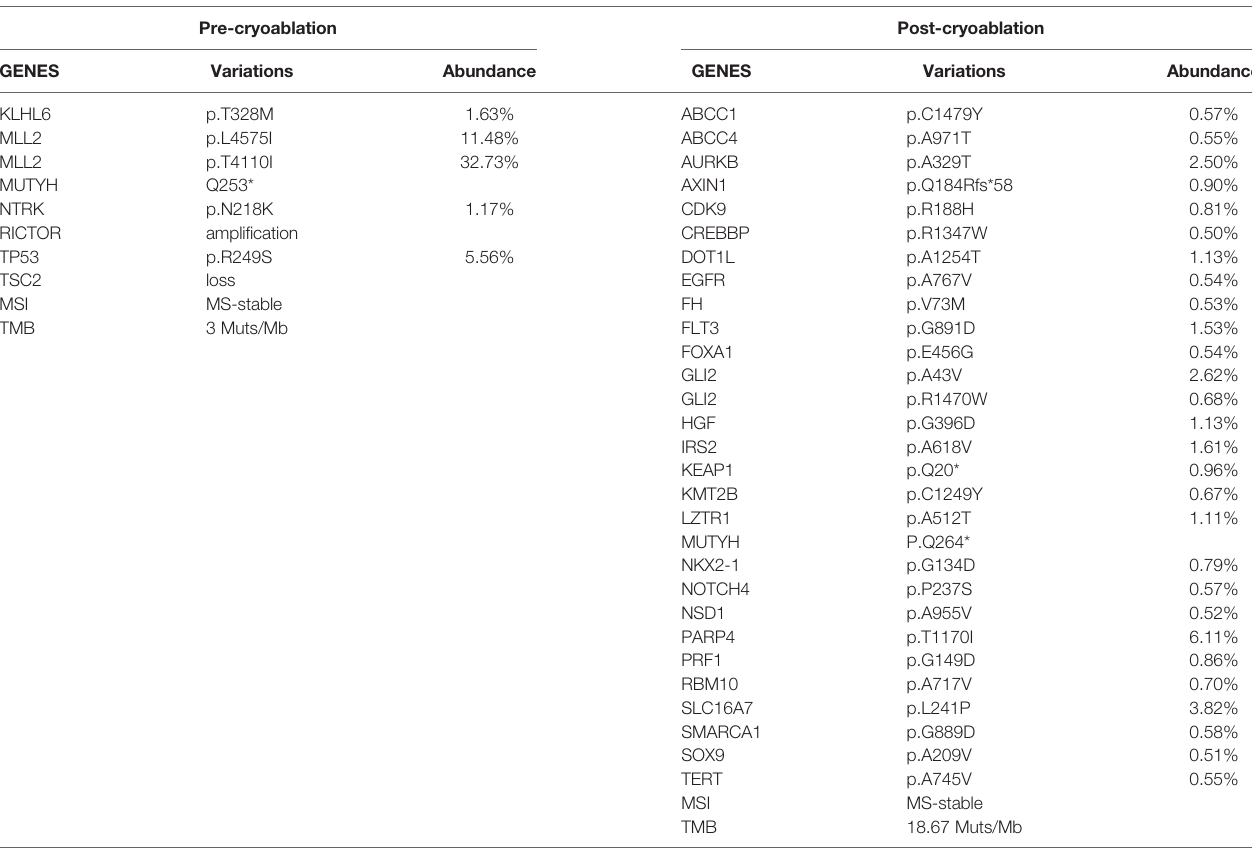
TABLE 1 | Summary of genetic test results.